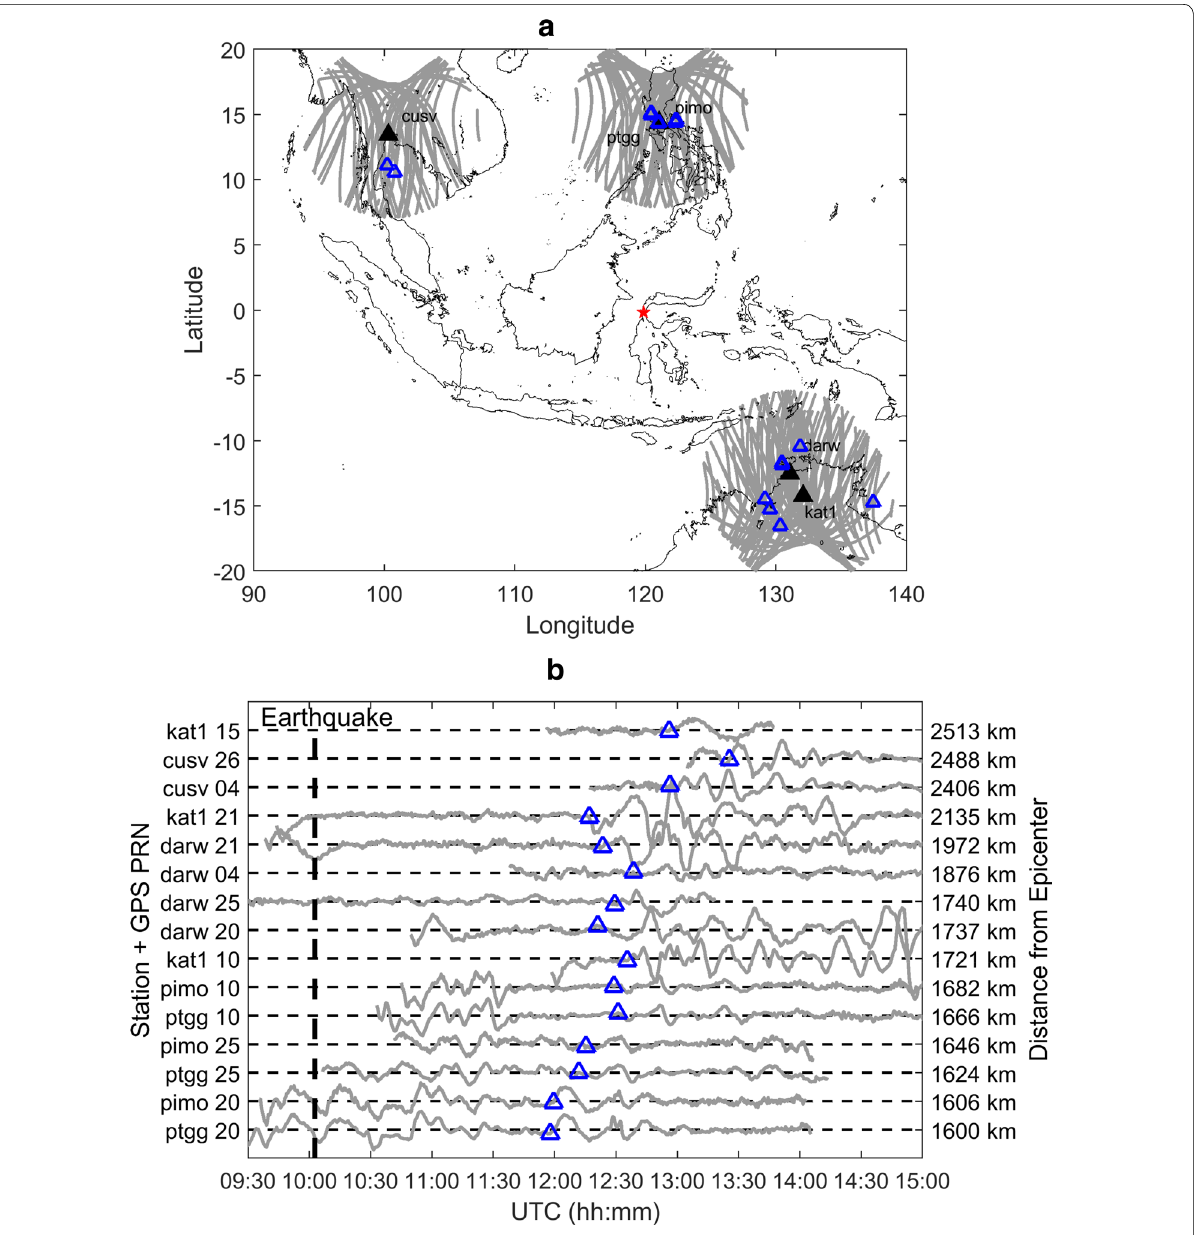
Fig. 1 The TTID signals of Sulawesi tsunami using GNSS TEC. a The locations of epicenter (red star) and GNSS receiving stations (black triangle). Blue open triangles denote the locations of TTID signals. b 15 detected TTIDs from 5 ground‑based GNSS stations are shown as black lines and blue triangles represent the start time of TTIDs. Black dash line indicates the occurrence time of